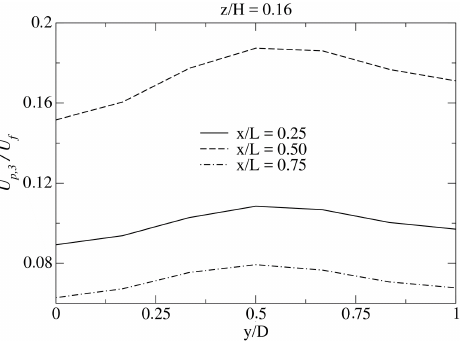
Figure 11. Profiles of the time-averaged normalized vertical velocity of the particulate phase ( U p ,3 / U f ) at different locations x / L . Simulation C2, µ w = µ p = 0.2, Re p = 70 and bed weight 75